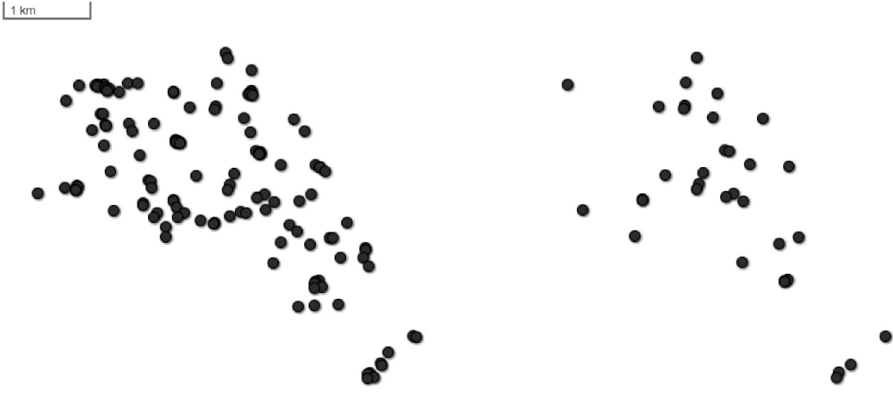
Figure 1. Distribution of all snapped trees ( left ) and the presence of nests of carpenter ant, Camponotus ligniperdus (Latreille, 1802), ( right ) in our study area in the Czech Republic.